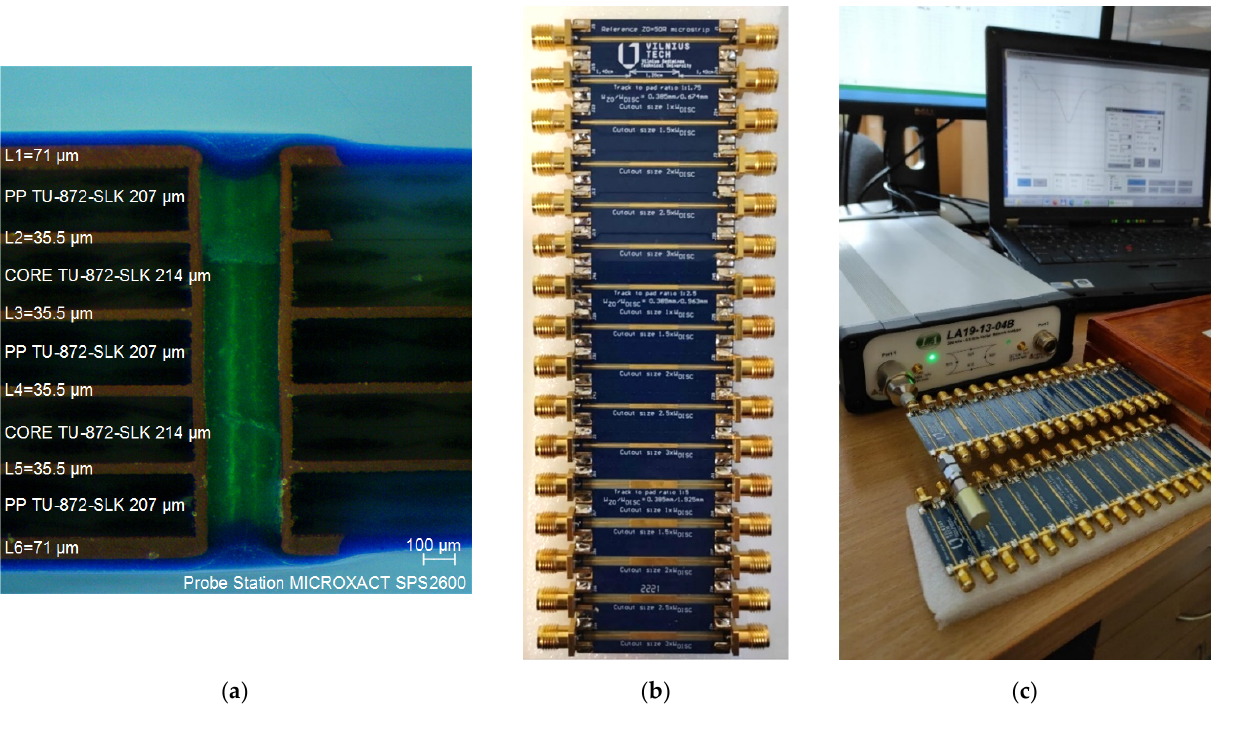
Figure 2. Manufactured 6-layer PCB with DUT structures: ( a ) optical microscopy evaluation; ( b ) top view; ( c ) measurement test-bench with LA19-1304B VNA.